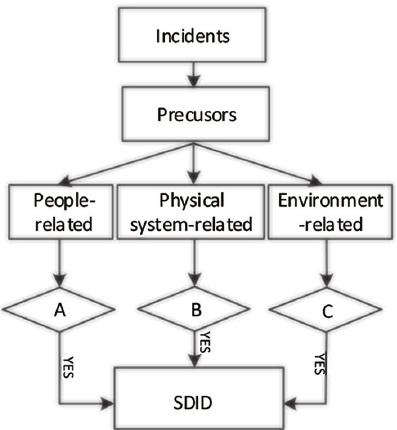
Figure 3. Subway design-incident classification model (SDICM)